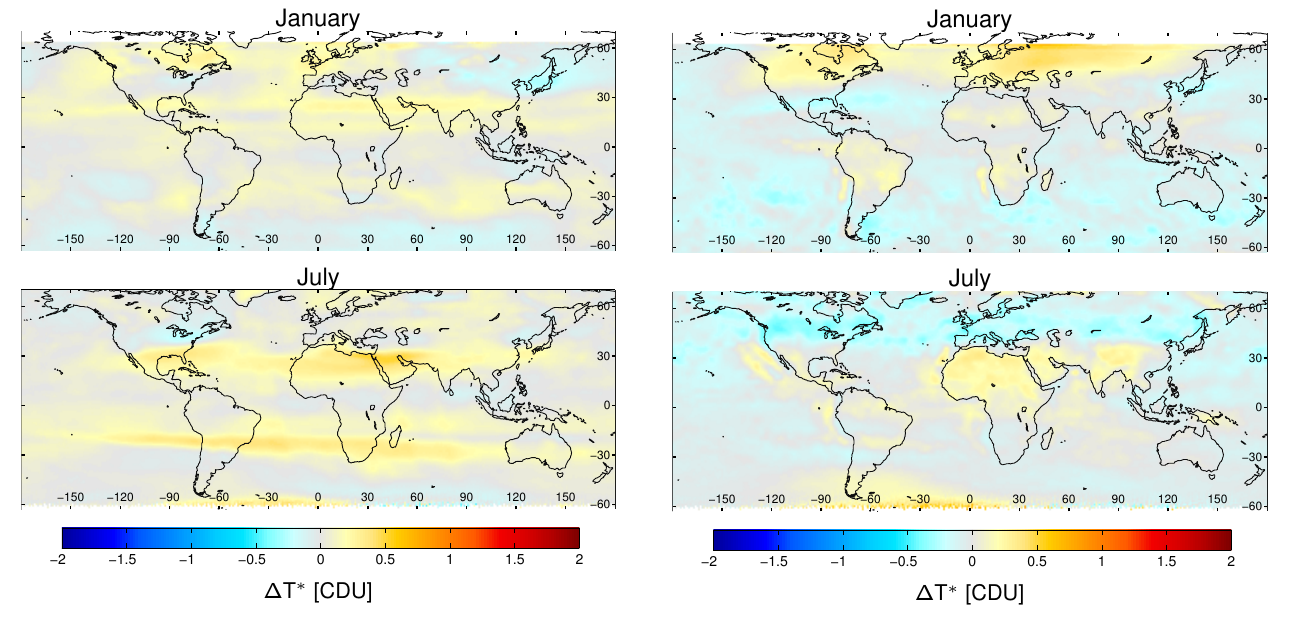
Figure 11. Monthly mean difference of tropospheric residues T ∗ from STS EMAC and STREAM for OMI measurements in Jan- uary (top) and July (bottom)